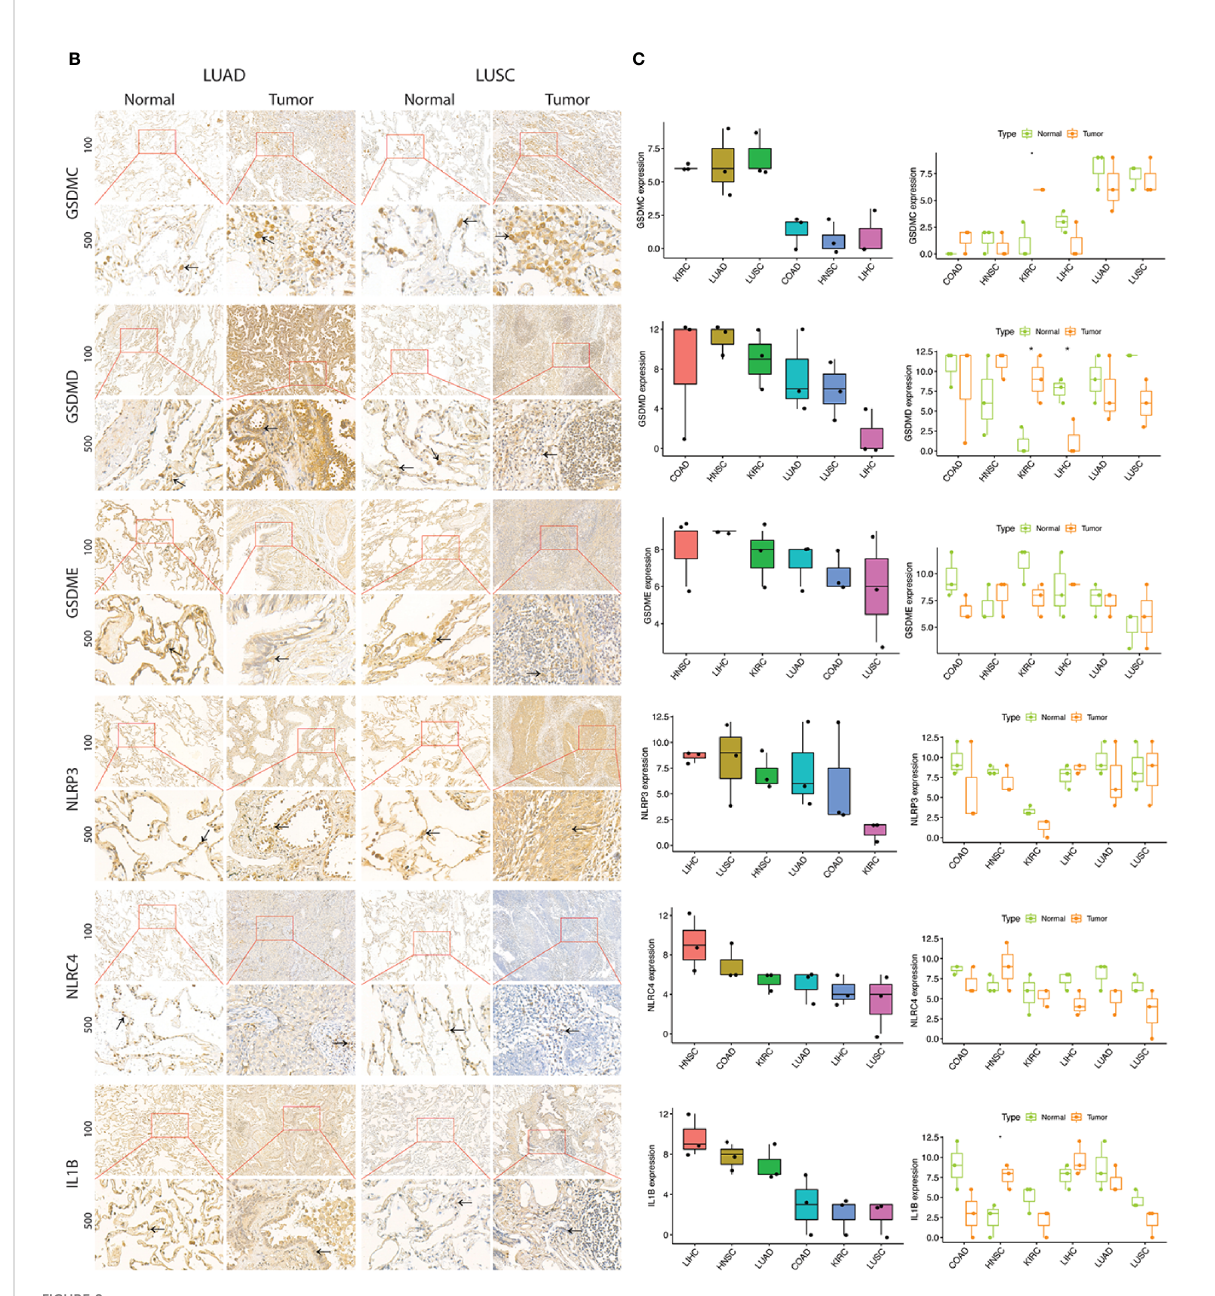
FIGURE 8 Expression of selected PRGs in clinical samples. (A) Representative images of expression (brown, cell cytoplasmic/nucleus stain) of GSDMC, GSDMD, GSDME, NLRP3, NLRC4, and IL1B in the clinical samples of colon adenocarcinoma (COAD), head & neck squamous cell carcinoma (HNSC), kidney renal cell carcinoma (KIRC), liver hepatocellular carcinoma (LIHC), lung adenocarcinoma (LUAD), and lung squamous cell carcinoma (LUSC). (B) Expression level (IHC quanti fi cation) of PRGs in the clinical samples of colon adenocarcinoma (COAD), head &. Neck squamous cell carcinoma (HNSC), and kidney renal cell carcinoma (KIRC), liver hepatocellular carcinoma (LIHC), lung adenocarcinoma (LUAD), and lung squamous cell carcinoma (LUSC). (C) Differential expression (IHC quanti fi cation) of PRGs in the clinical samples of colon adenocarcinoma (COAD), head &. Neck squamous cell carcinoma (HNSC), and kidney renal cell carcinoma (KIRC), liver hepatocellular carcinoma (LIHC), lung adenocarcinoma (LUAD), and lung squamous cell carcinoma (LUSC). P values are shown as: *P<0.05; **P < 0.01; ***P < 0.001